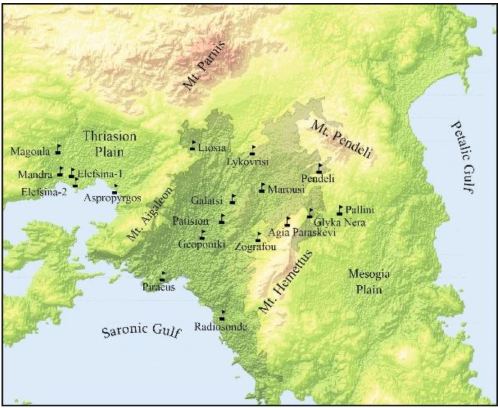
Figure 6. Spatial distribution of the routine measuring sites in the Greater Athens Area. The shadowed area represents the Athens Metropolitan